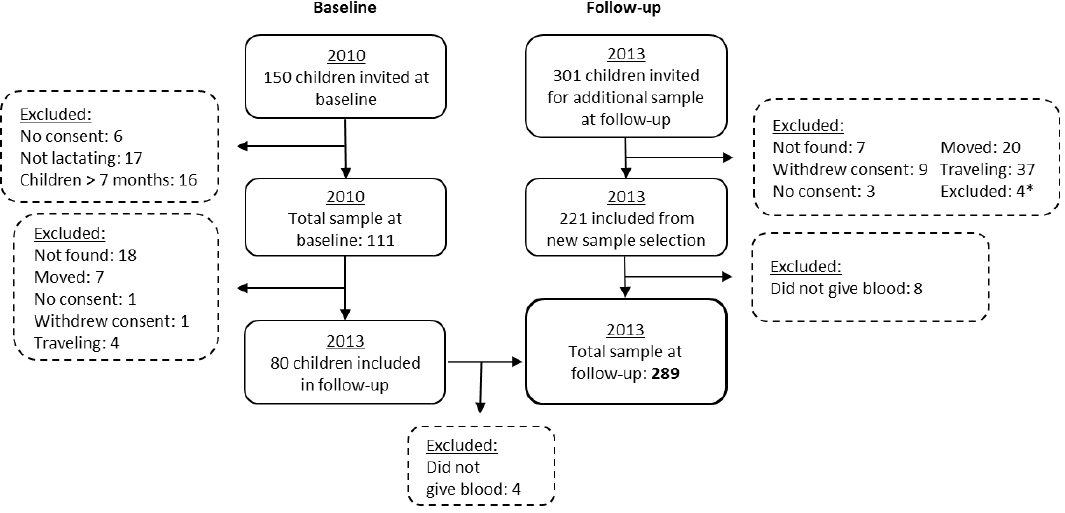
Figure 1. Flowchart for selection of Saharawi children at baseline (2010) and follow-up (2013). * low age, high age, deaf and mute.